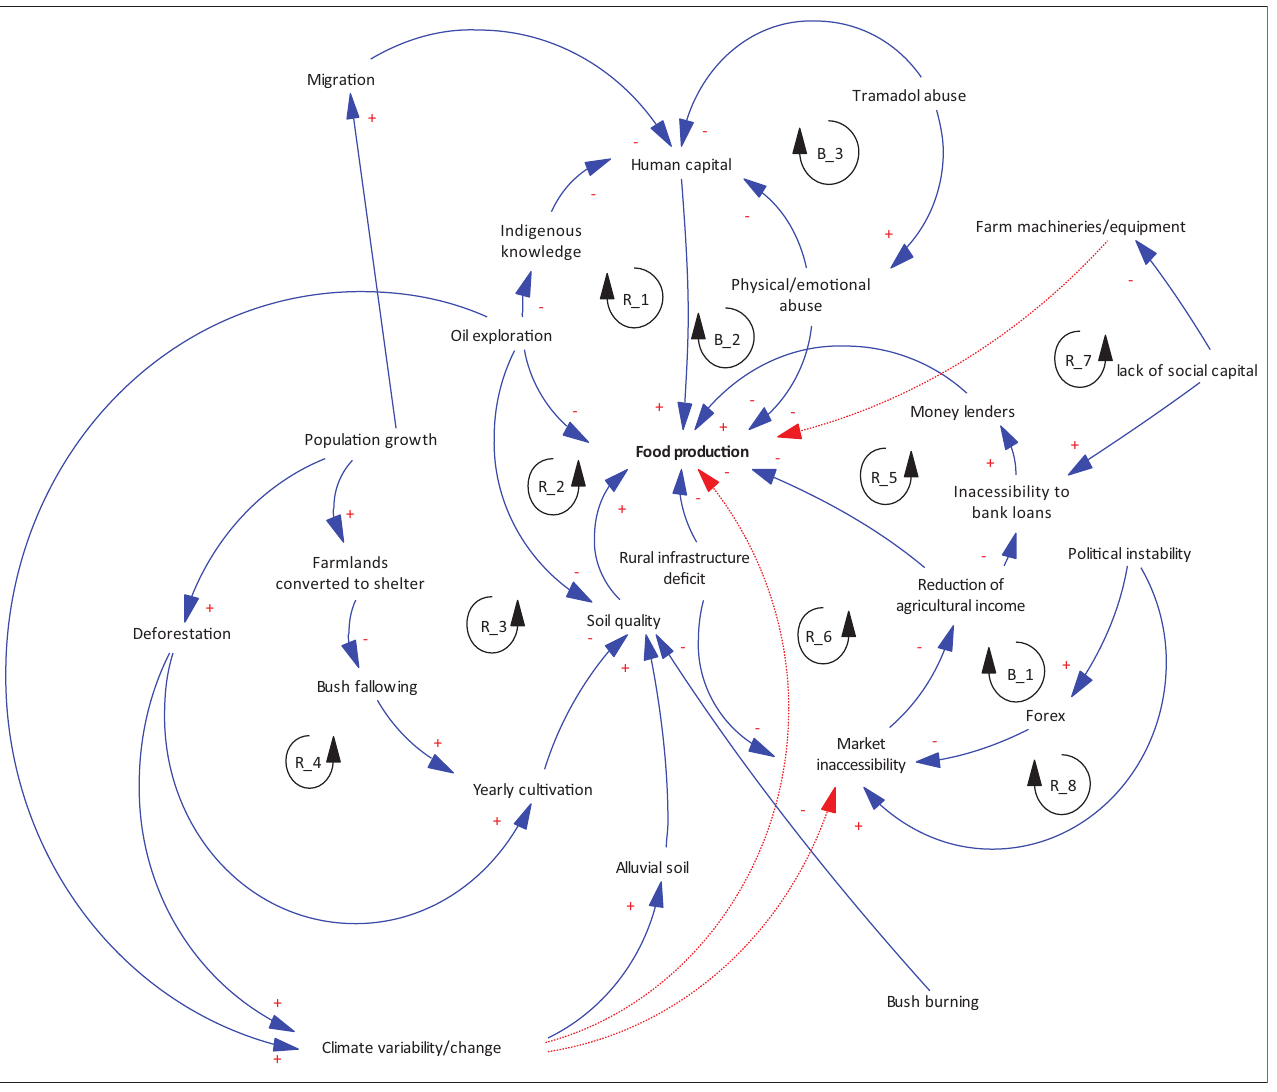
FIGURE 3: Systems model of factors undermining effective food production in the study areas. Dashed lines have no influence on the loop they pass